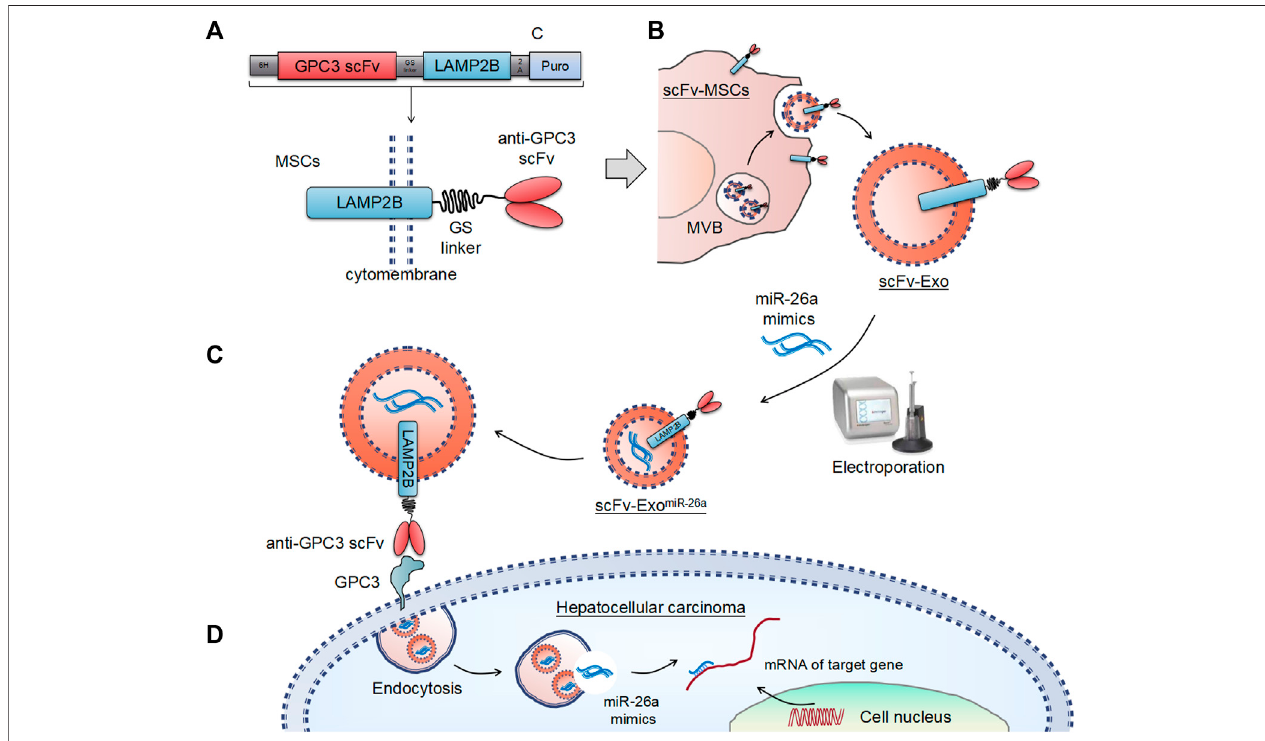
FIGURE 1 | Schematic illustration of the exosome-based drug delivery systems. (A) Design of the anti-GPC3 scFv-Lamp2b fusion constructs. (B) Schematic representation of the exosomes-based nanosystem preparation. (C) Uptake of anti-GPC3 scFv-modi fi ed exosomes by tumor cells. (D) Schematic illustration of the antitumor mechanisms of miR-26a